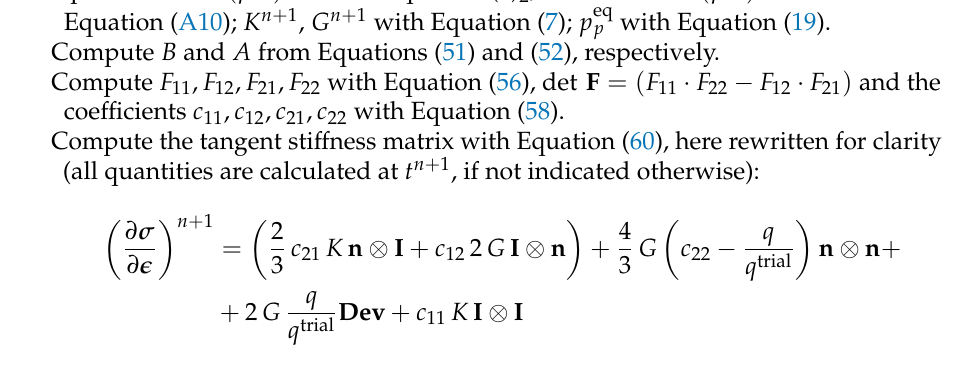
(cid:17) n + 1 (cid:16) ∂ σ , Equation ∂ (cid:101)